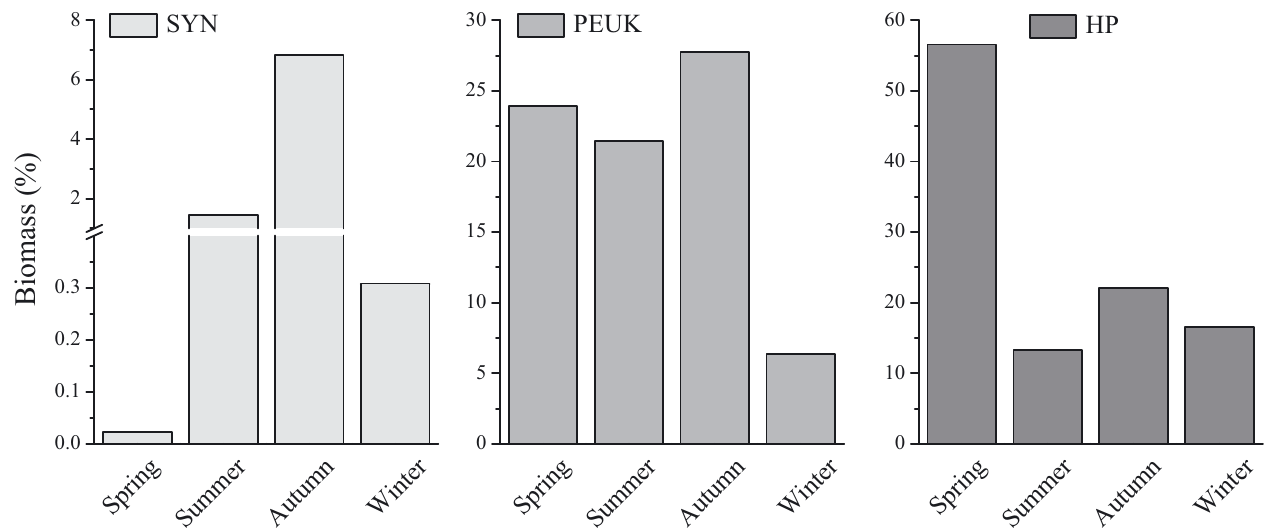
Fig. 6. Biomass contribution of Synechococcus (SYN), picoeukaryotes (PEUK) and heterotrophic prokaryotes (HP) to total phytoplankton biomass in Sanggou Bay over 4 successive seasons. The total phytoplankton biomass was derived from chloro- phyll a concentration. Note different y -axis